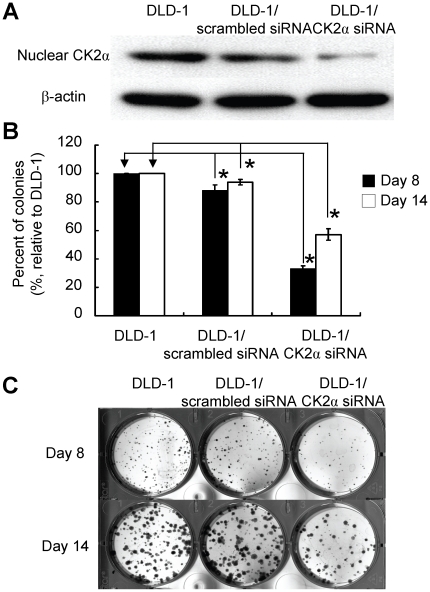
Effect of CK2α gene silencing on colon cancer
cell proliferation.
Panel A. Nuclear CK2α expression in siRNA treated and
un-treated DLD-1 colon cancer cells was examined by Western blot
analysis. Panel B. Histograms representing the cell
proliferation assay results based on the average of three independent
experiments. *denotes P<0.001 compared with
un-treated DLD-1 cells. Panel C. The representative
photomicrographs.